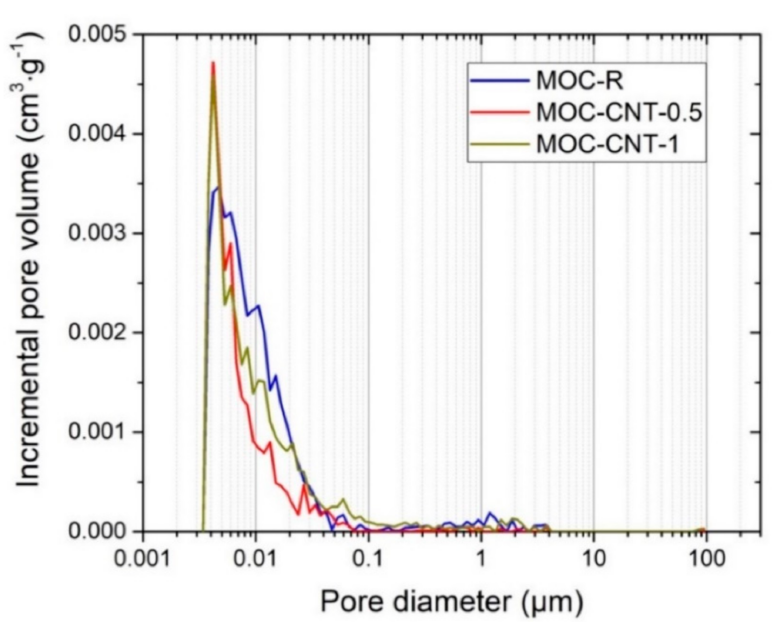
Figure 6. Incremental pore volume distribution of the investigated composites.